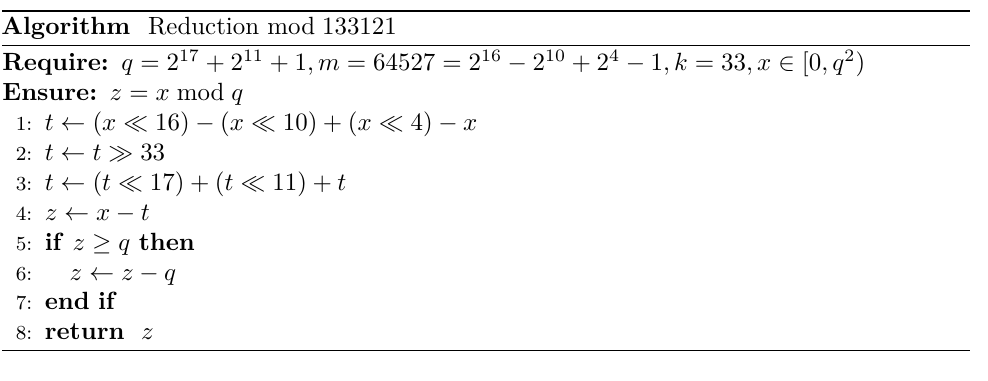
Algorithm Reduction mod 133121